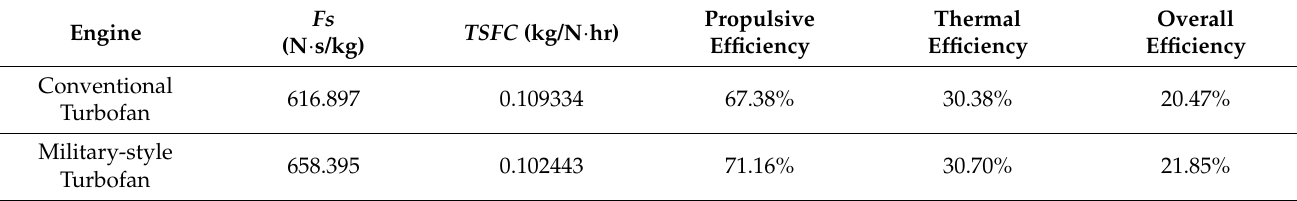
Table 3. Performance with Bypass Ratio Fixed at 0.5.